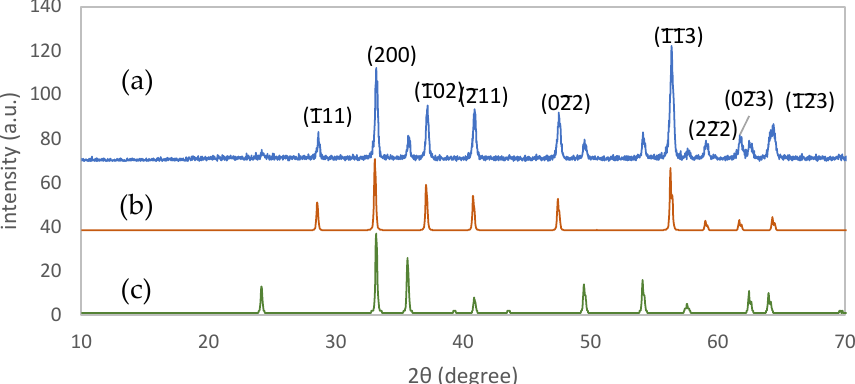
Figure 10 . The SEM Image of the cross ‐ section of pyrite thin film on FTO. The thickness of the two layers, FTO and pyrite, is compared by dashed arrows. The black arrow shows some impurities which are deposited on the surface of the thin film.